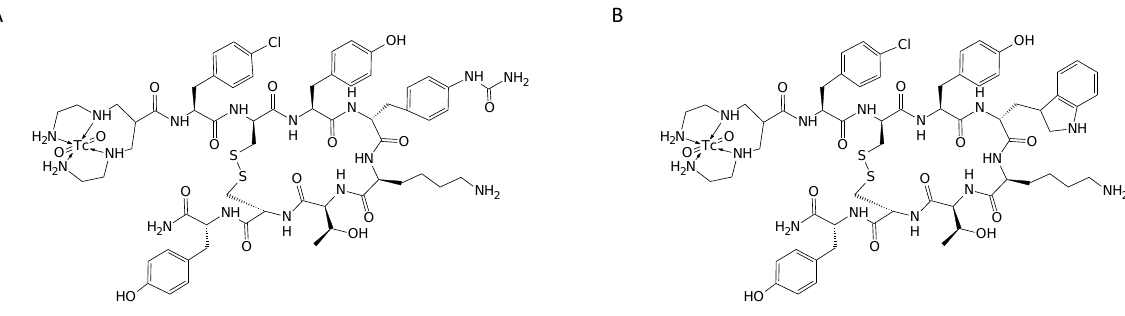
Scheme 1. The chemical structure of [ 99m Tc]Tc-TECANT-1 ( A ) and [ 99m Tc]Tc-TECANT-2 ( B Scheme 1: The chemical structure of [